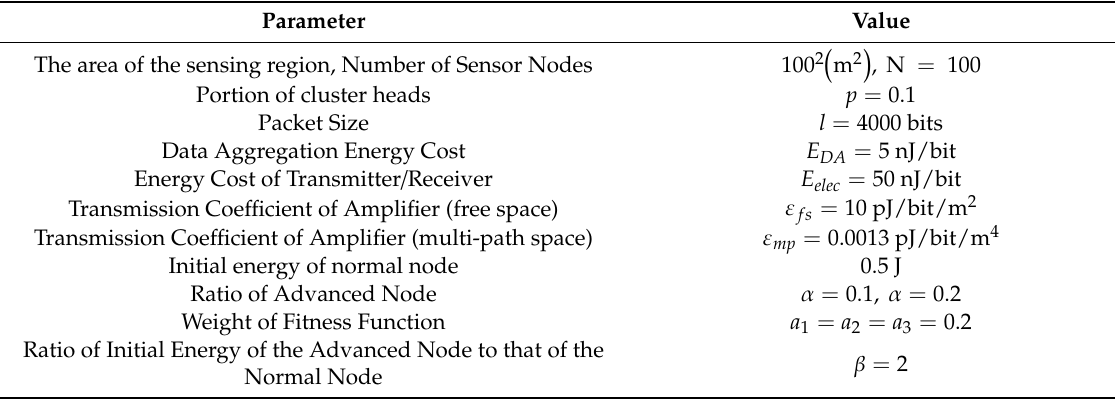
Table 2. Simulation